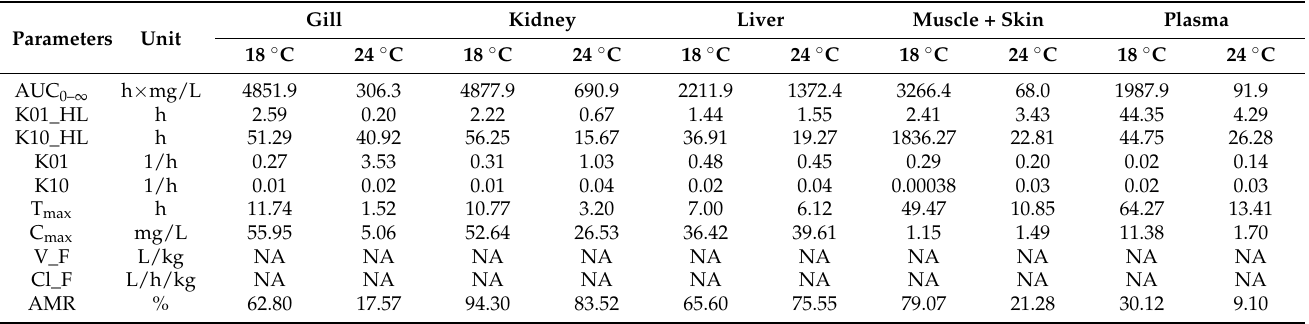
Table 4. Pharmacokinetic parameters of N-acetyl sulfadiazine in gill, kidney, liver, muscle + skin and plasma of grass carp ( Ctenopharyngodon idella ) after orally administered sulfadiazine at a dose of 50 mg/kg at 18 and 24 ◦